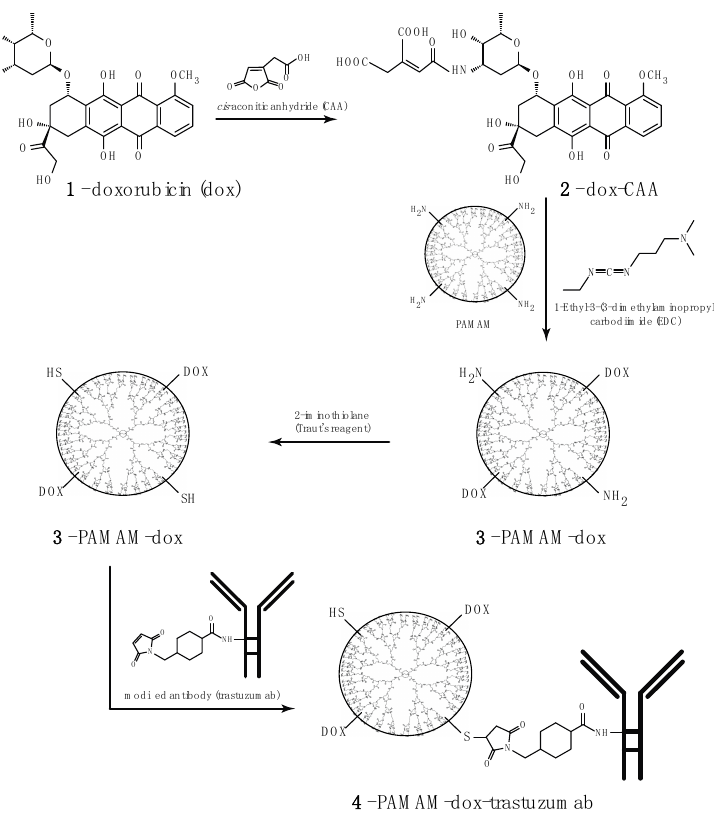
Figure 1. Synthesis of PAMAM–dox–trastuzumab conjugate.